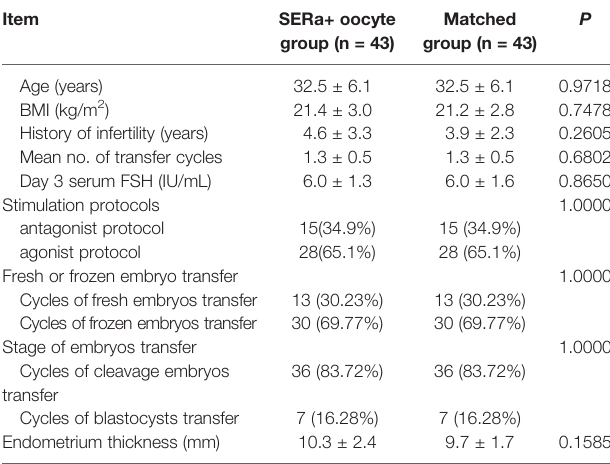
*SERa, aggregates of smooth endoplasmic reticulum.